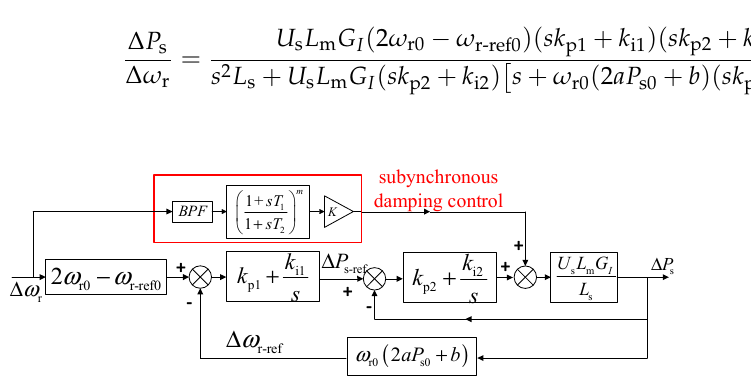
Figure 5. Control diagram of DFIG stator active power varying with rotor speed.